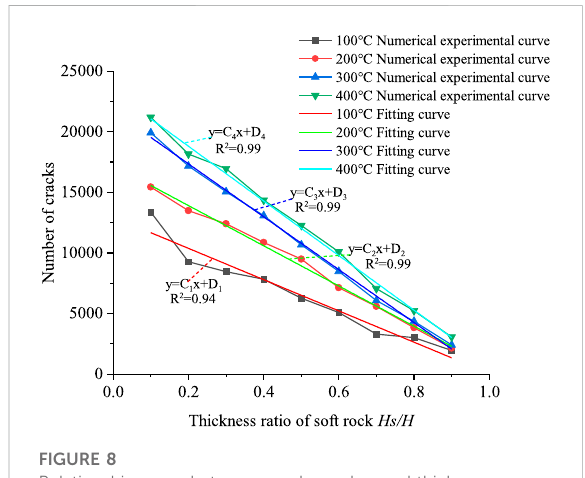
FIGURE 8 Relationship curve between crack number and thickness ratio of soft rock ( Hs/H ) under different loading temperatures.